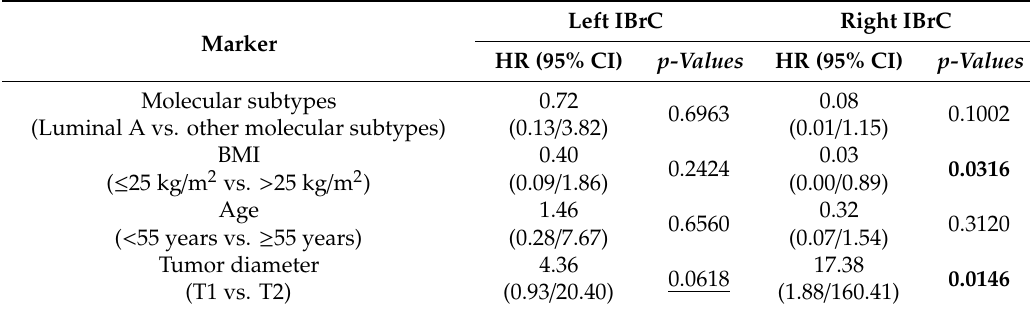
Table 6. Multivariate Cox’s hazard ratios for progression-free survival according to selected clinicopathological features with respect to left- and right-sided tumors. Left IBrC Marker